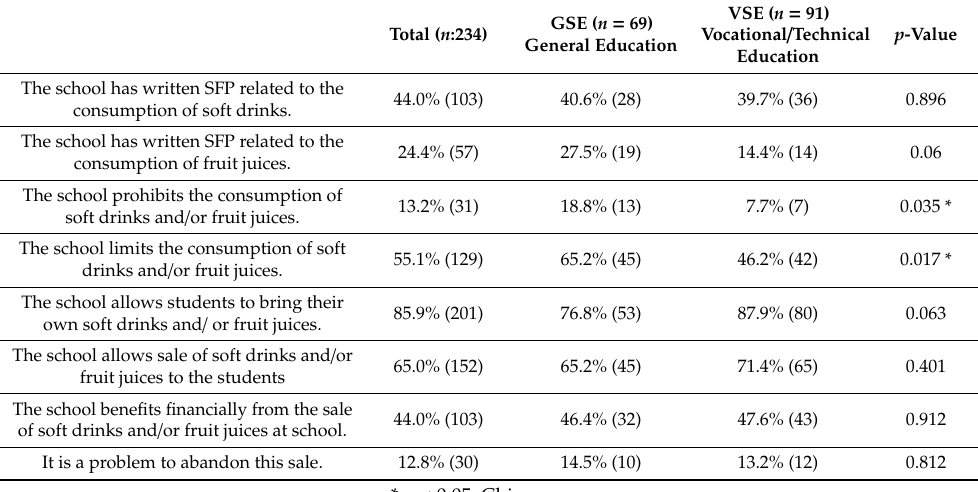
Table 2. School Food Policies (SFP) Related to Soft Drink and Fruit Juice Consumption in Flanders, Belgium and Comparison by Education